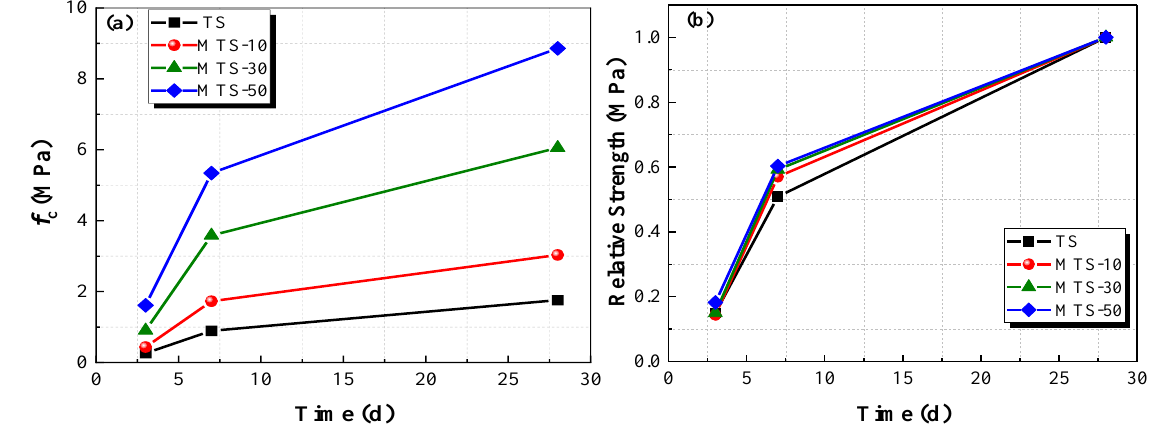
Figure 11. ( a ) Unconfined compressive strength and ( b ) relative strength. Figure 11 demonstrates that the unconfined compressive strength and content of CACG exhibited a positive correlation. The unconfined compressive strength of MTS- 50 cured for 28 days reached up to 8.86 MPa, which is 5.03 times, 2.92 times, and 1.46 times that of TS, MTS-10, and MTS-30, respectively. The relative strength presented similar trends